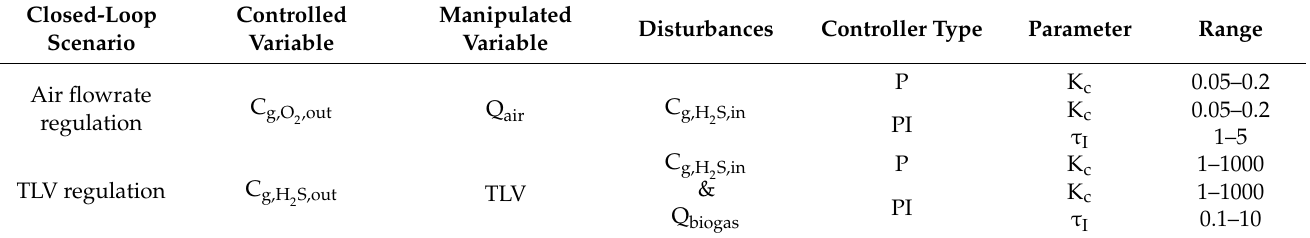
Table 3. Summary of Closed-Loop scenarios and control strategies